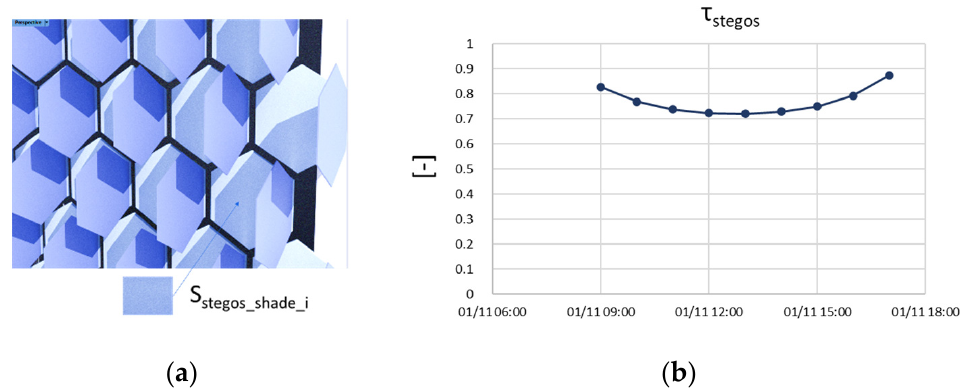
Figure 15. ( a ) The shaded surface on the Stegos is the sum of all S Stegos_shade_i . ( b ) Simulated τ Stegos for the 1 November (data for location: Bordeaux, France).